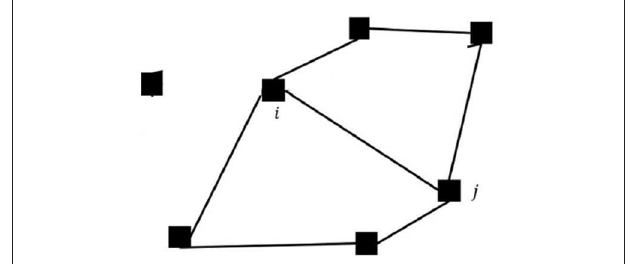
FIGURE 12 | The rendezvous network after this group of agents has been desynchronized due to the existence of a disturbance. Agent 3 is disconnected from all the neighbors, and the network was split into two sub-graphs.